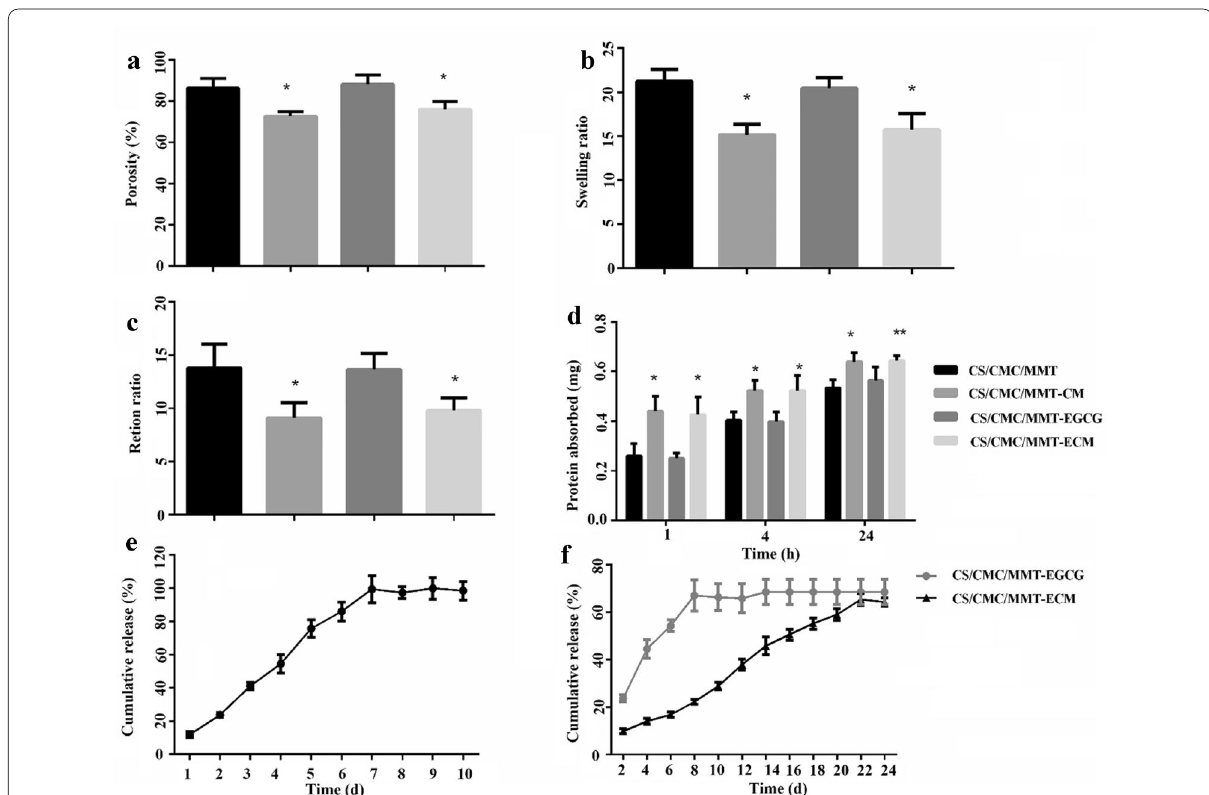
Fig. 6 a The mean pore size of prepared scaffolds. b The water uptake of scaffolds. c The retention rates of scaffolds. d Enzymatic degradation of the scaffolds. * P < 0.05, ** P < 0.01. e The release curve of EGCG from the ECM. f The release curve of EGCG from the CS/CMC/MMT‑EGCG and CS/